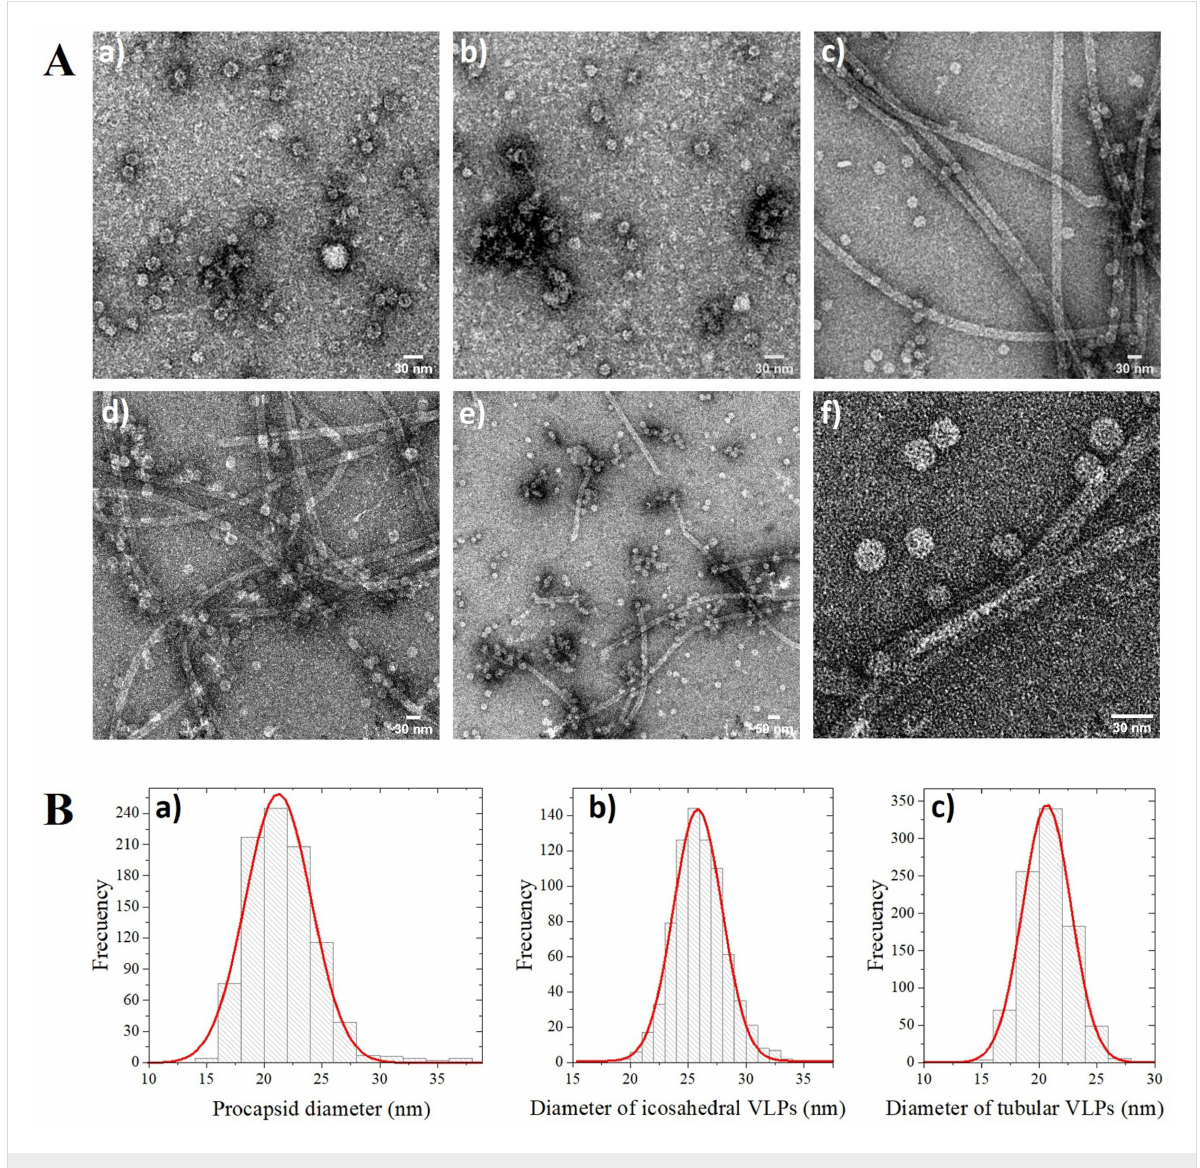
Figure 2: TEM micrographs of different stages of the assemblies of CCMV CP with dsRNAvp28. In section A, the images a) and b) correspond to the assembly in virus buffer; c) and d) are acidified assembly; e) and f) images correspond to the sample that was dialyzed again in assembly buffer. Section B shows the size distributions of the ensembles: a) diameter distribution of the procapsids with a mean diameter peak at 21 nm; b) diameters of the icosahedral VLP-dsRNAvp28 with a mean diameter peak at 26 nm and c) diameter of the tubular structures with a mean diameter peak at 21